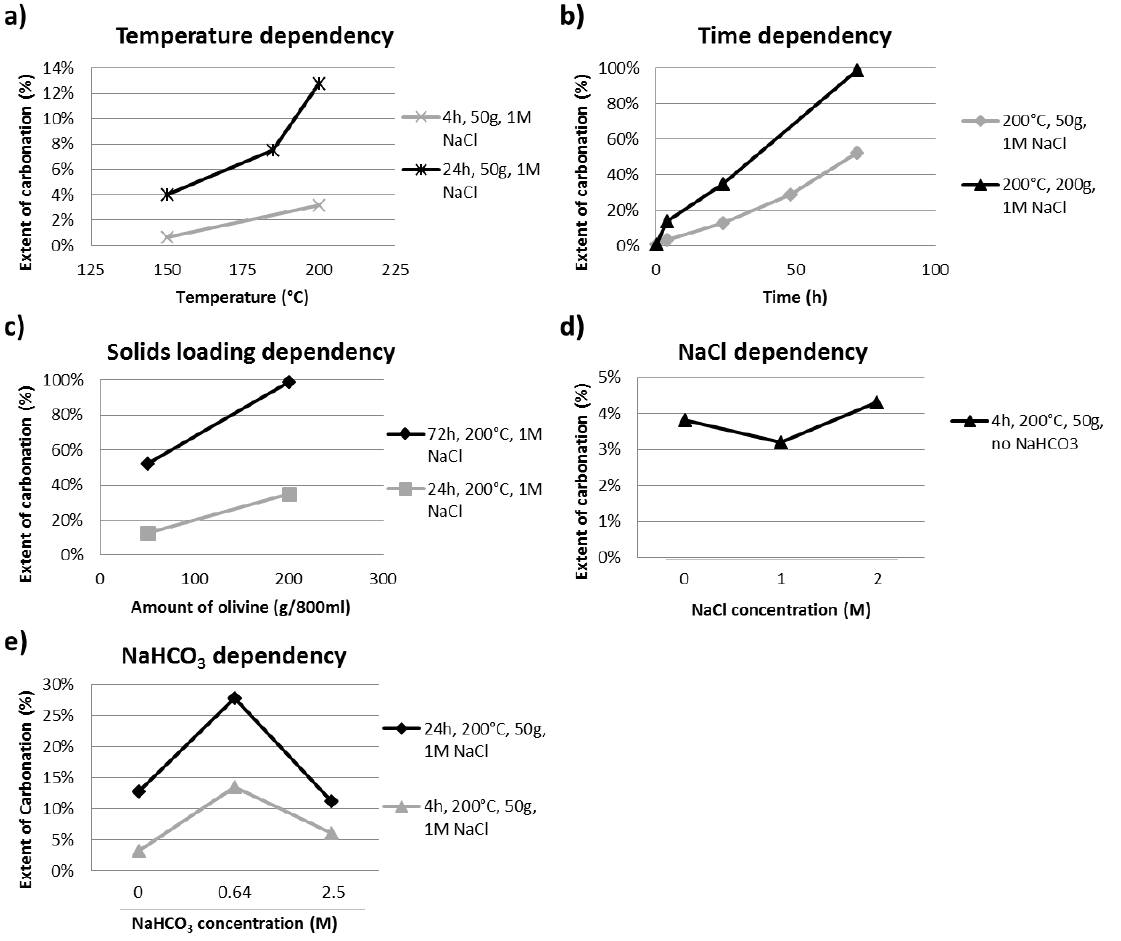
Figure 3. Influence of carbonation process parameters (temperature ( a ); residence time ( b ); solids loading ( c ); NaCl concentration ( d ); and NaHCO 3 concentration ( e )) on extent